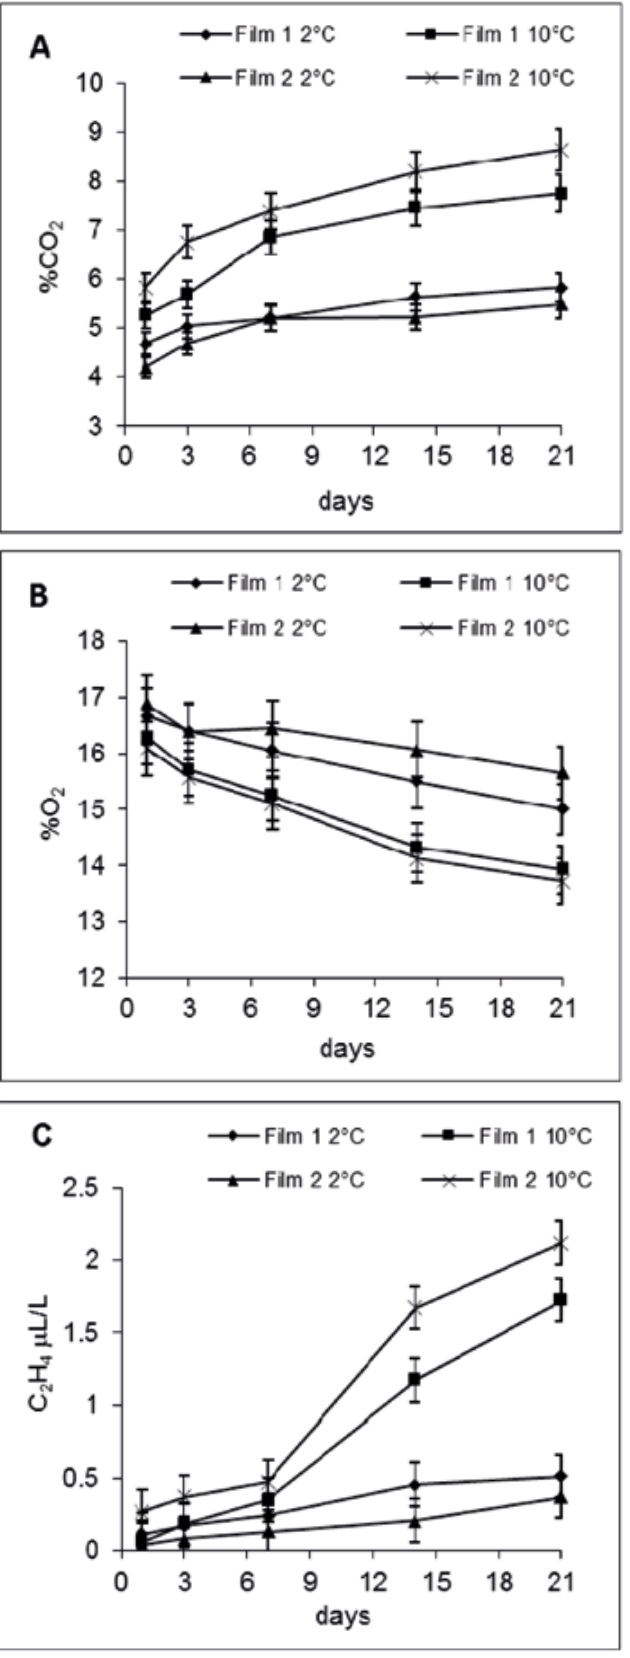
Fig. 1 - Influence of film packaging (Film 1, Omnifilm PVC film; Film 2, Bolphane BX polyolefinic film) and storage conditions on in- (A), O (B) and ethylene levels (C). Vertical bars package CO 2 2 represent the standard deviation. LSD are given at the 5% level.